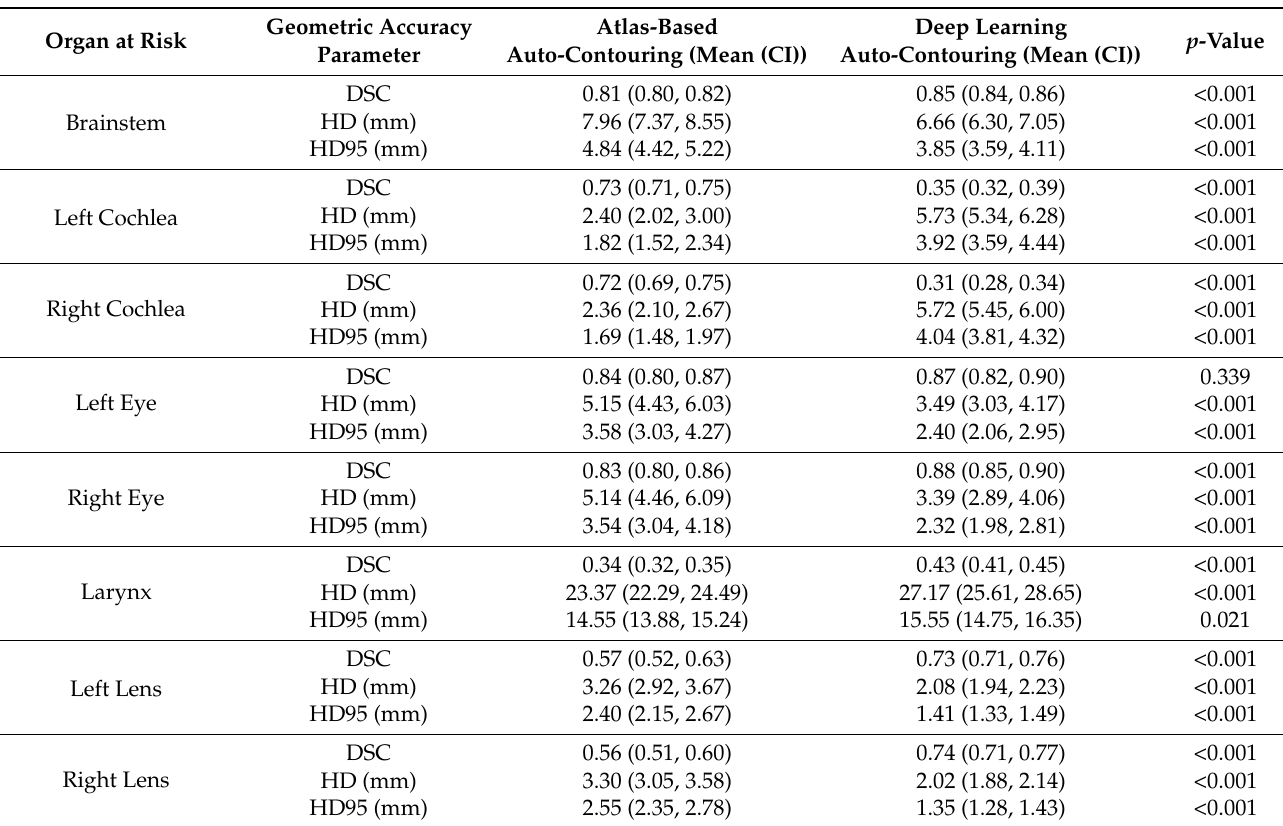
Figure 2. Boxplots of three geometric accuracy evaluation parameters, Dice similarity coefficient ( A ), Hausdorff distance ( B ), and 95th-percentile of Hausdorff distance ( C ) for organs at risk contoured by atlas-based and deep learning (DL) auto-contouring approaches. L-left; R-right. Table 2. Comparison of geometric accuracy of contours between atlas ‐ based and DL auto ‐ contouring.